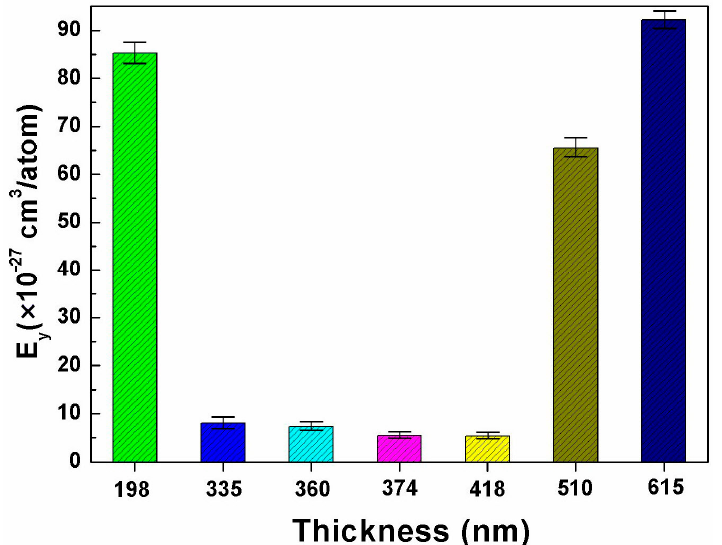
Figure 9. Relationship between the atomic oxygen erosion yield and the coating thickness.